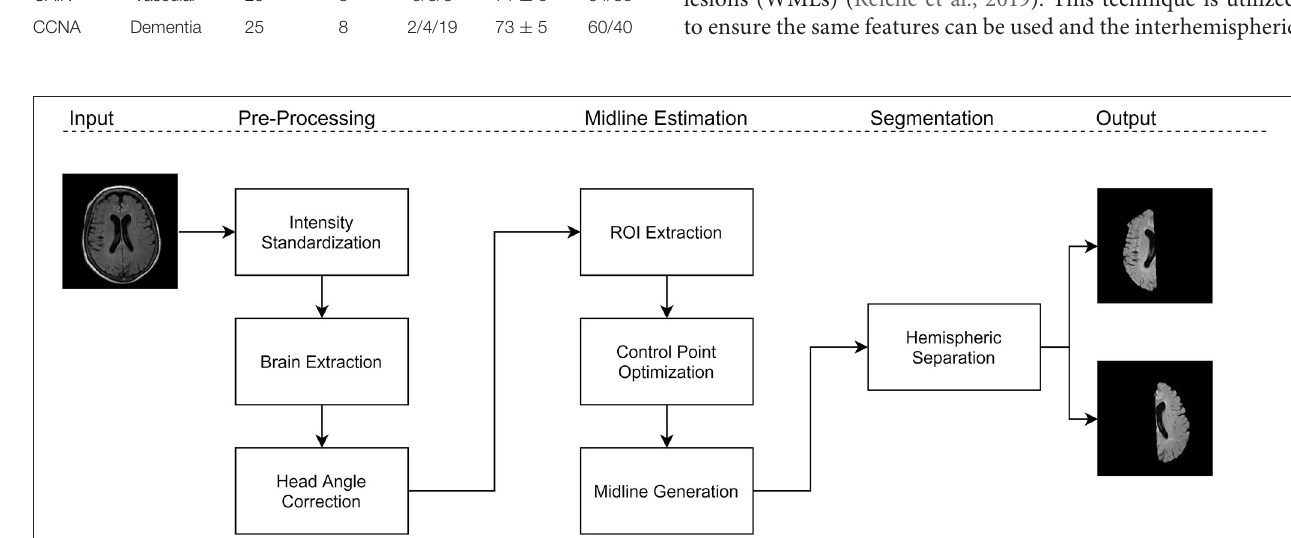
FIGURE 1 | Experimental design for the proposed